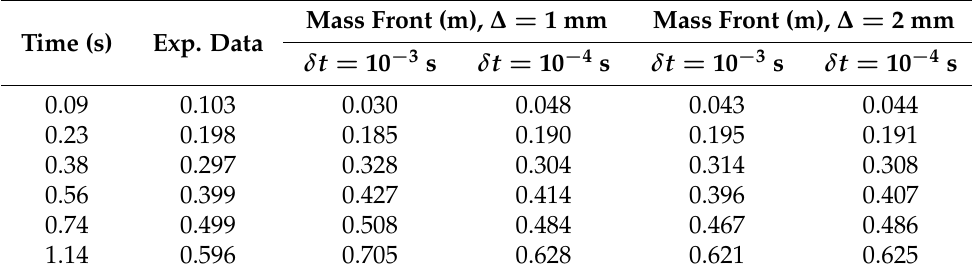
Table 1. Mass front position obtained numerically and experimentally for six time